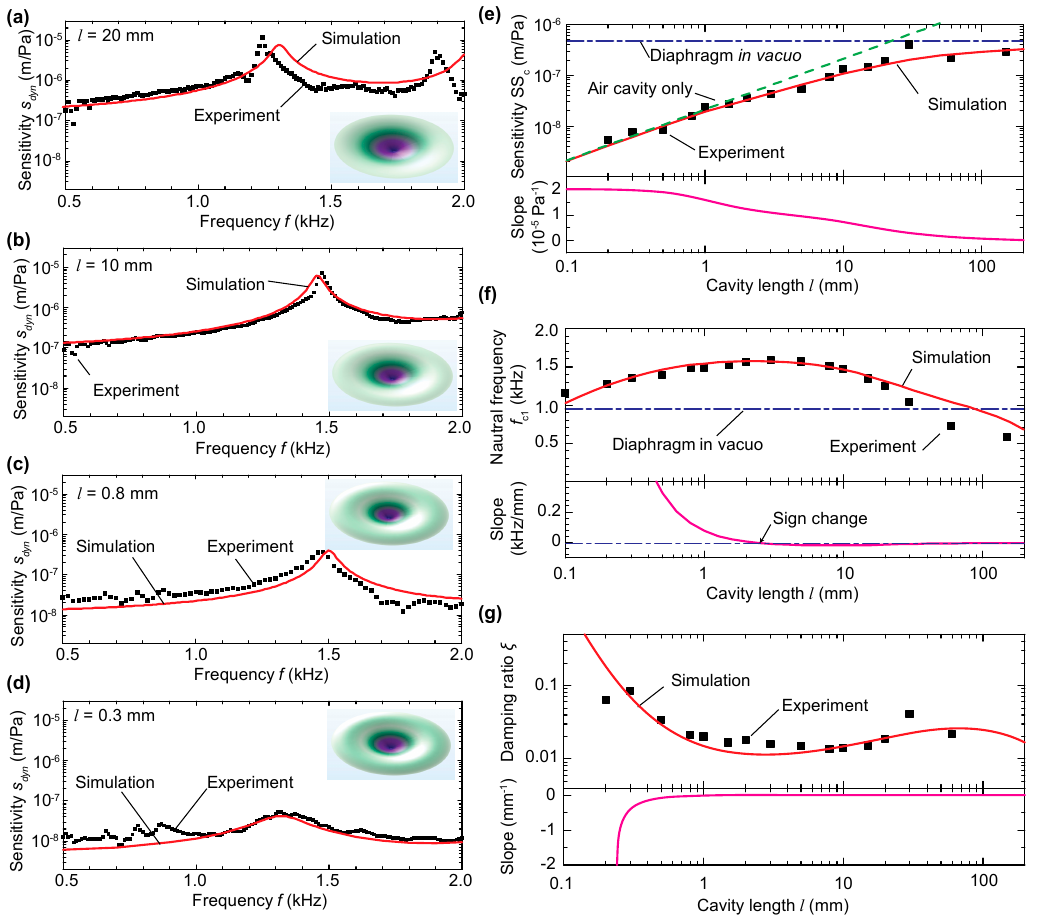
Figure 4. Experimental results in comparison with the simulations. ( a – d ): Frequency response function (i.e., mechanical sensitivity as a function of frequency) for different cavity lengths ( l = 20 mm, 10 mm, 0.8 mm, and 0.3 mm), where the simulation results were obtained using the COMSOL Thermoviscous Acoustics module. The insets show the mode shapes for the fundamental mode. ( e – g ): mechanical sensitivity ( e ), natural frequency ( f ), and damping ratio ( g ) as a function of cavity length. The curves in the bottom of ( e – g ) show the slopes of the simulated data.